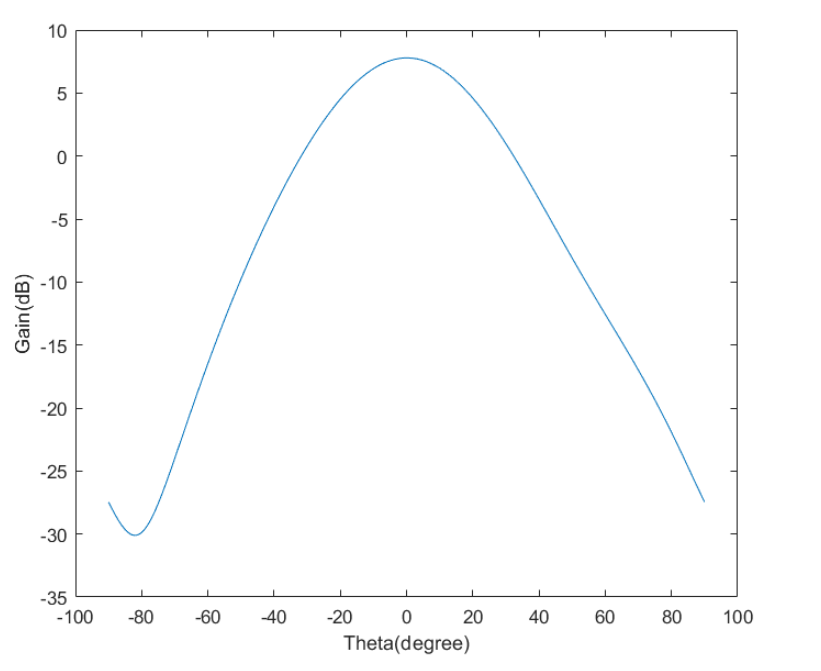
Figure 6. Microstrip antenna model.